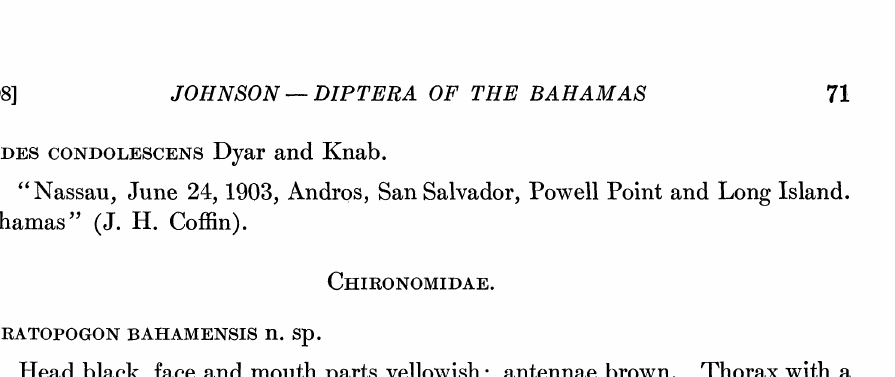
ground color of dark brown or black, covered with a grayish pollen, showing in certain light three indistinct stripes; pleurae reddish or dark brown, with whitish pollinose; scutellum dark yellow; metanotum black, grayish pollinose. Abdomen black, seg- ments with a narrow posterior margin of light yellow, renter yellow. tips of the femora, tibiae and all the joints of the tarsi narrowly banded with black. Halters yellow. Wings